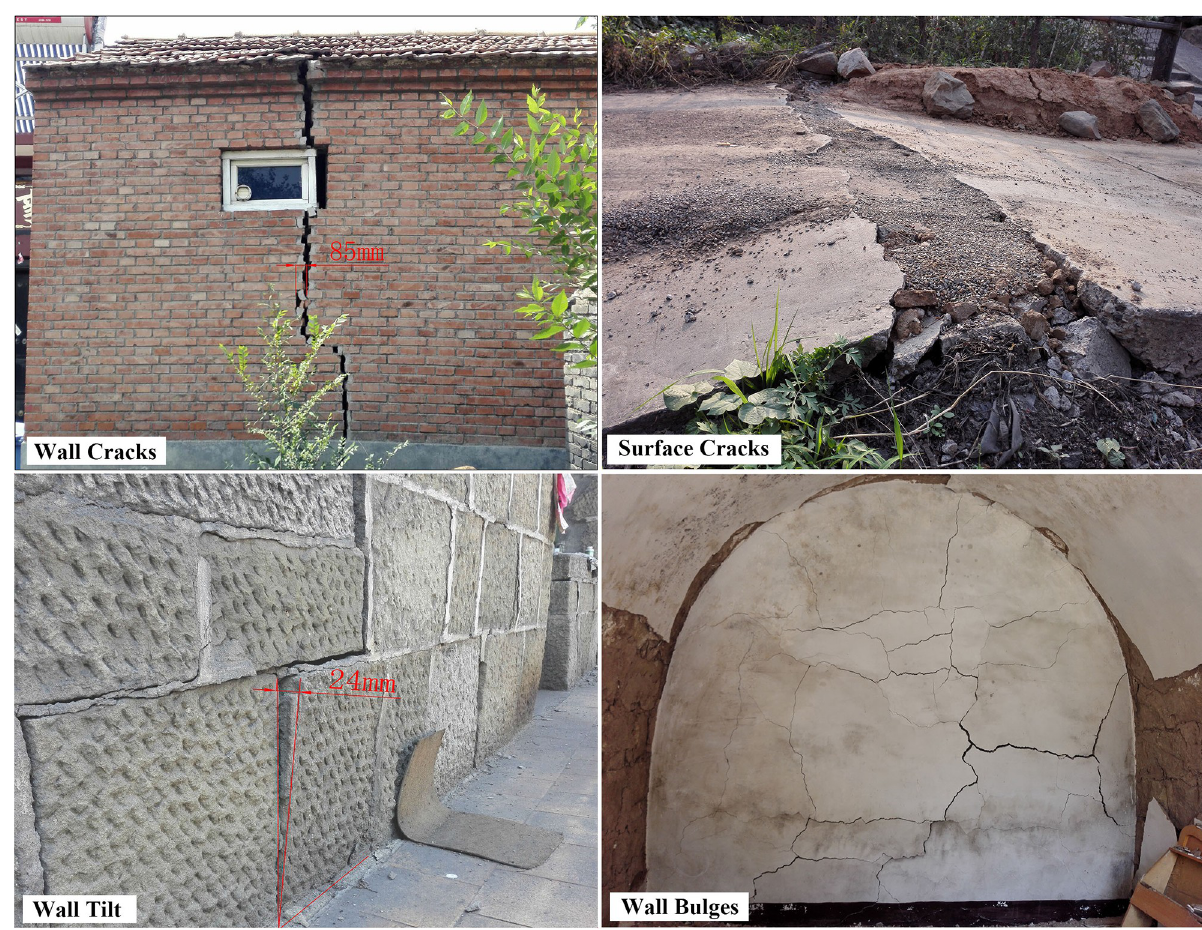
Fig 2. Examples of damage to village buildings. (A) Wall cracks. (B) Surface cracks. (C) Wall tilt. (D) Wall bulges.